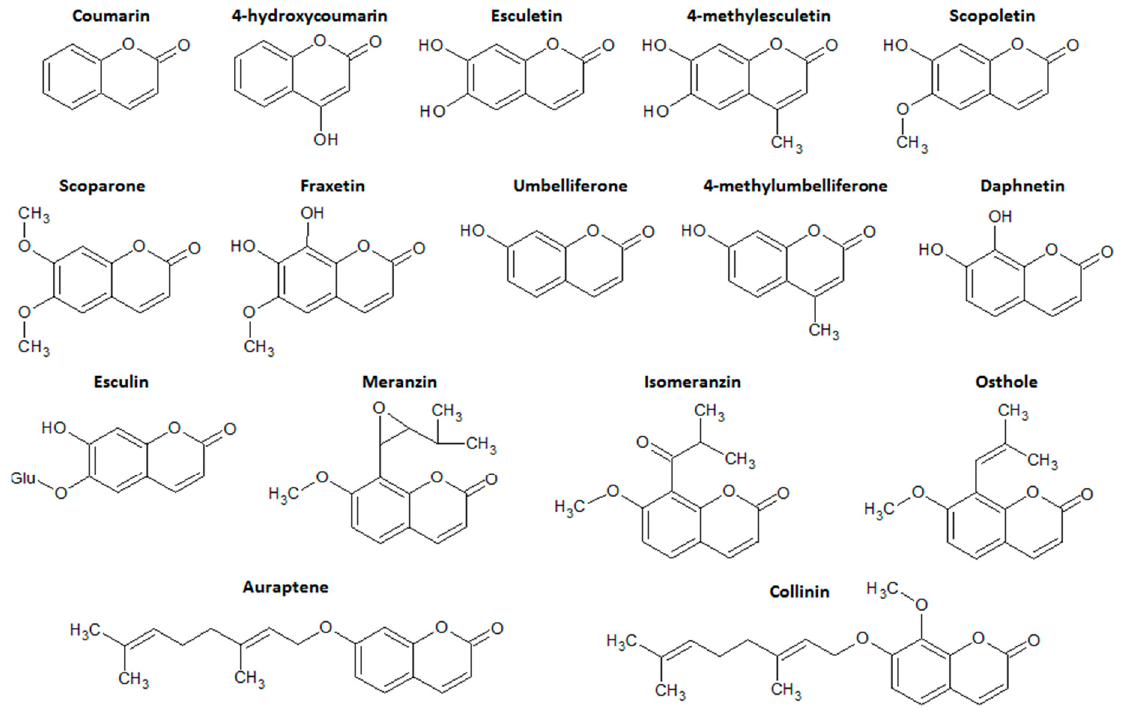
Figure 2. Chemical structures of the main simple coumarin derivatives with intestinal anti ‐ inflammatory activity. Chemical structures were drawn using ACD/ChemSketch software.